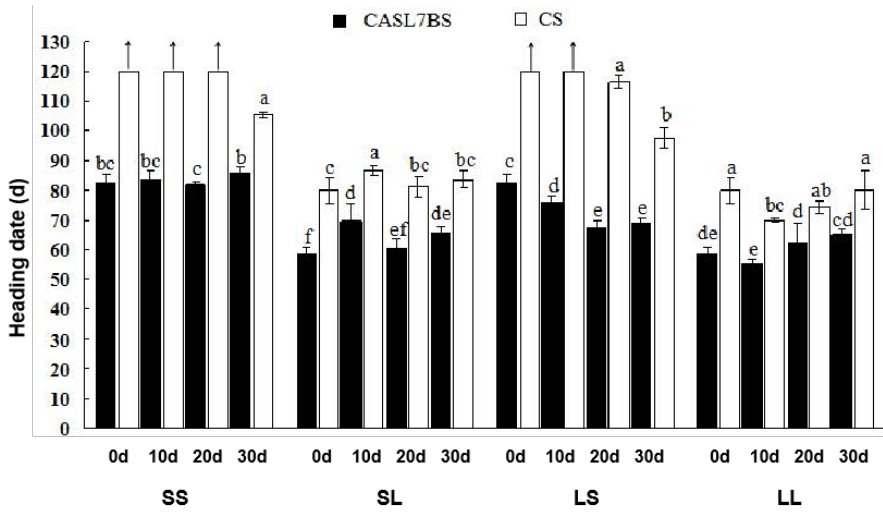
Figure 4. Heading date of CASL7BS and CS under different vernalization and photoperiod treatments. Arrows on the top of the white bars represent that the plants still do not head after growing for 120 d, which cannot be analyzed for significant difference. SS: vernalization and grown under short day; SL: vernalization under short day, but grown under long day; LS: vernalization under long day, but grown under short day (SD); LL: vernalization and grown under long day (LD). LD: 16 h light/8 h dark; SD: 8 h light/16 h dark. The letters represent the significance at p < 0.05.